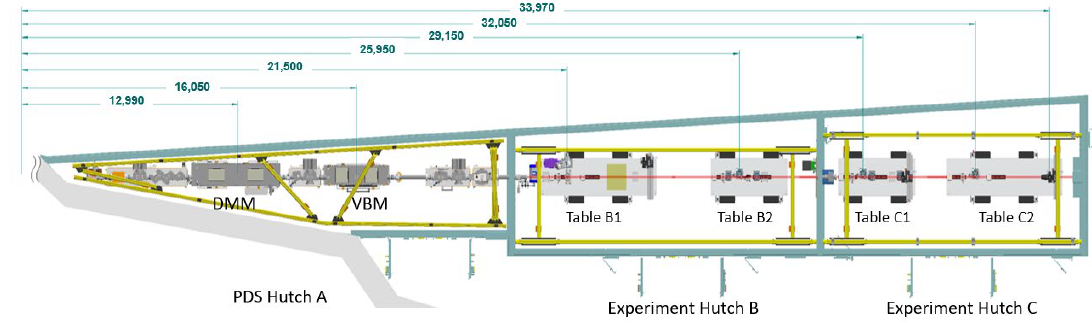
Figure 2. MCT beamline layout.